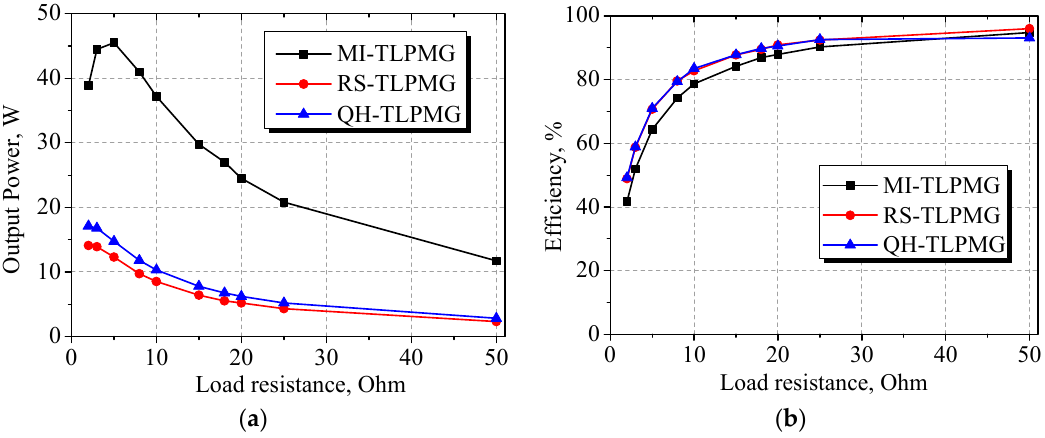
Figure 8. Output power and efficiency of the three generators with different resistance loads: ( a ) output power; ( b ) efficiency.